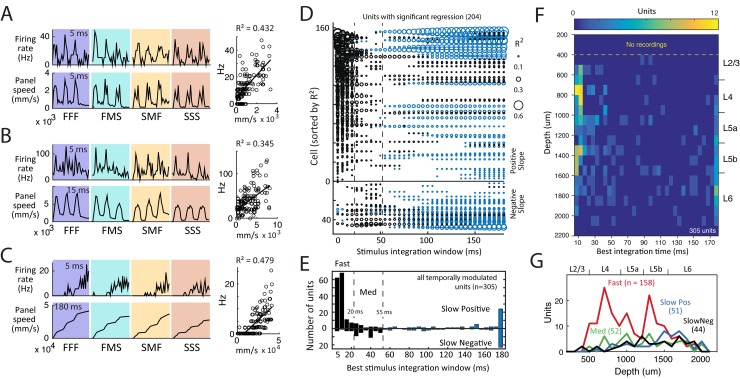
Classification of S1 units by stimulus regression.(A–C) Stimulus regression for three example units. Top, PSTH in 5 ms time bins. Bottom, stimulus panel speed integrated over 5, 15, or 180 ms, which was the best fit stimulus integration window for each unit. Right, regression of firing rate on integrated stimulus speed. (D) Coefficient of determination (R2) for all stimulus integration windows with a significant regression, for each unit with a significant regression to at least one window. Black: Fast and Medium time scale units (best integration window <55 ms). Blue: Slow units. Cells are sorted by peak R2 and by sign of the regression slope for the best integration window. (E) Number of units with each best integration window and positive or negative regression slope. (F,G) Laminar distribution of units by best integration window. Data for this figure are in S1 Data.